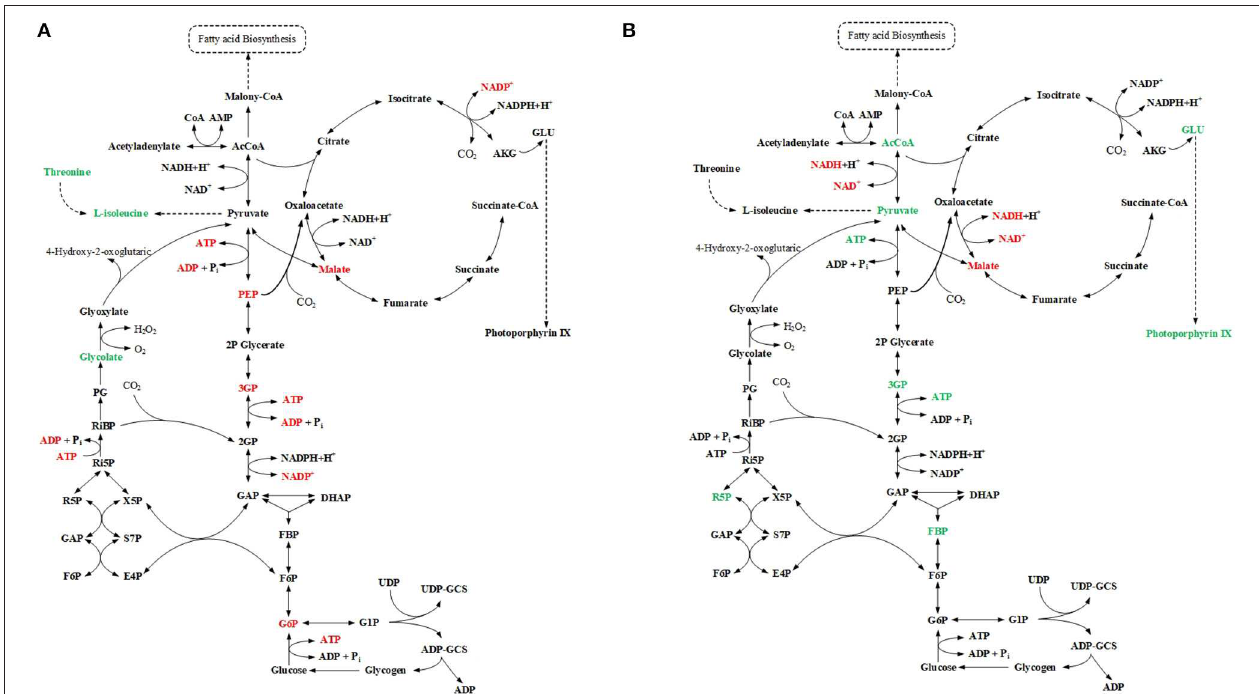
FIGURE 3 | Integrated analysis of GC-MS and LC-MS profiles. (A) Pathway view of metabolite changes in 1 sll1330 , differential regulated metabolites were represented by color, red for down-regulated and green for up-regulated. (B) Pathway view of metabolite changes in 1 slr6040 , differential regulated metabolites were represented by color, red for down-regulated and green for